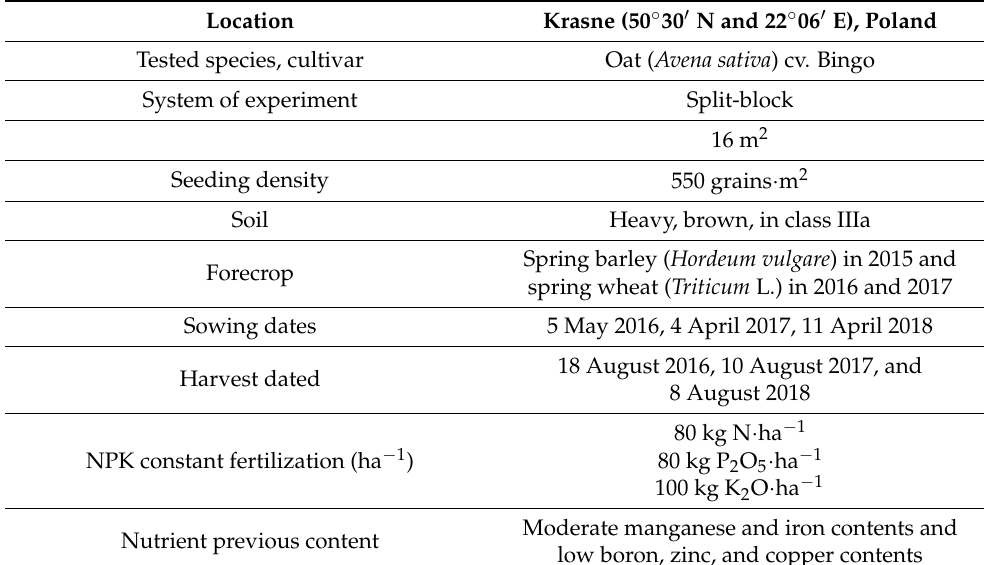
Table 2. Summary of the field experiment